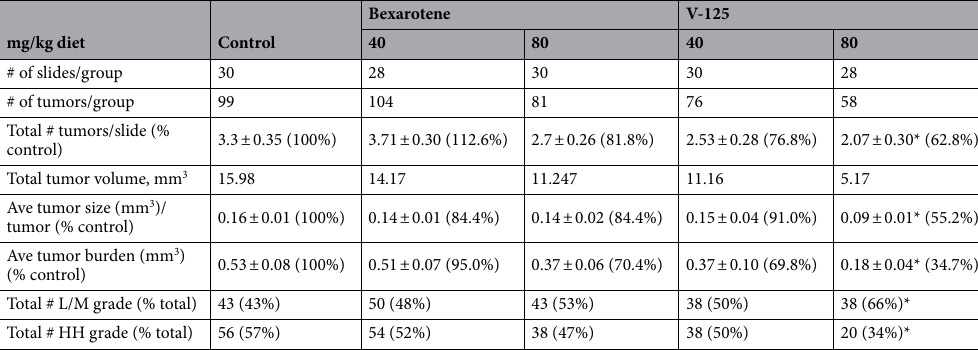
Table 1. V-125 reduces lung carcinogenesis in A/J mice. Female A/J mice were injected with vinyl carbamate and fed control diet or V-125 in diet for 16 weeks, as described in Fig. 2. L low, M medium, H high. *P < 0.05 vs. control.